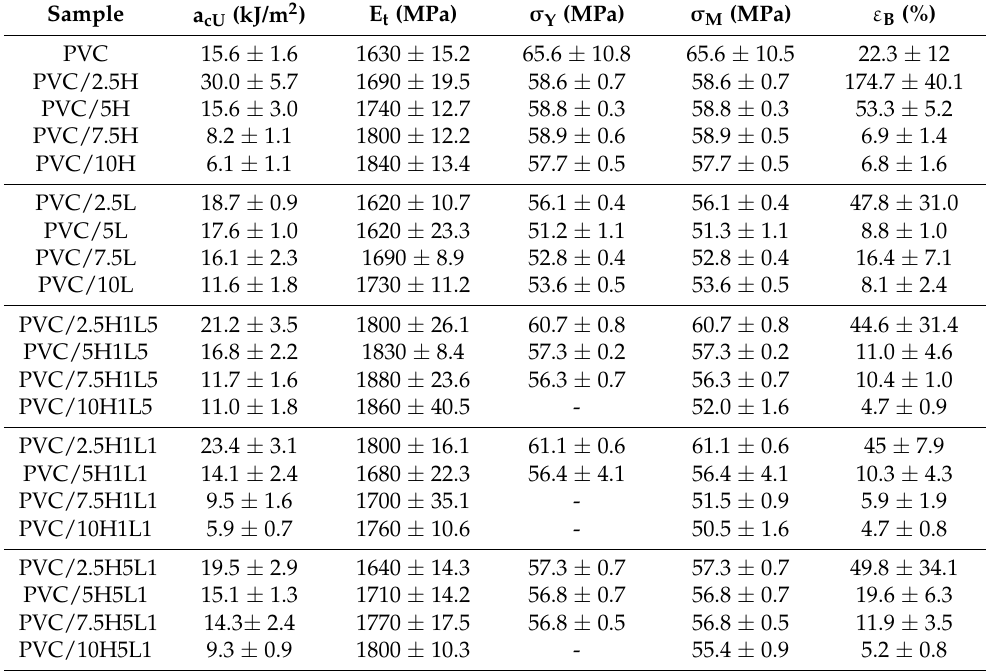
Table 5. Mechanical properties of PVC and PVC composites with halloysite, lignin and halloysite – lignin hybrid fillers.